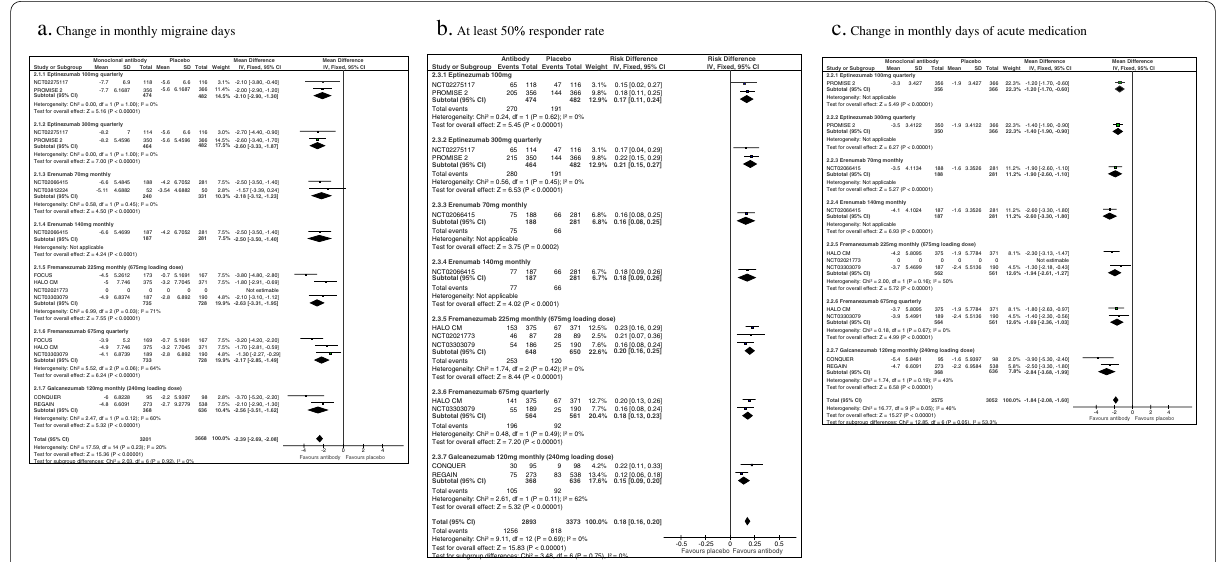
Fig. 4 Forest plots of comparison: 2 Monoclonal antibodies vs placebo ‑ Chronic